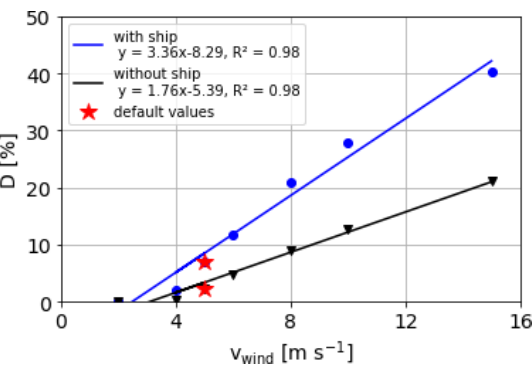
Figure 7. Dependence of the downward dispersion D on different exit velocities v exit with and without the obstacle